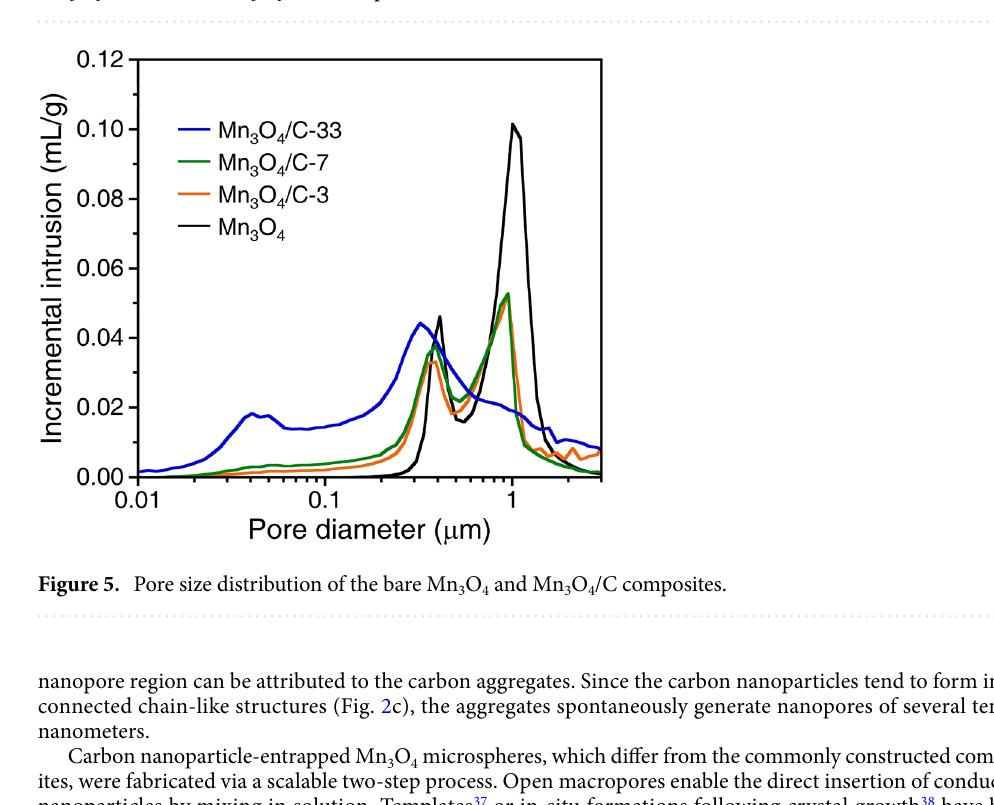
Figure 4. ( a – e ) SEM images and ( f ) XRD patterns of the Mn 3 O 4 /C composite samples: ( a ) Mn 3 O 4 /C-3, ( b , d , e ) Mn